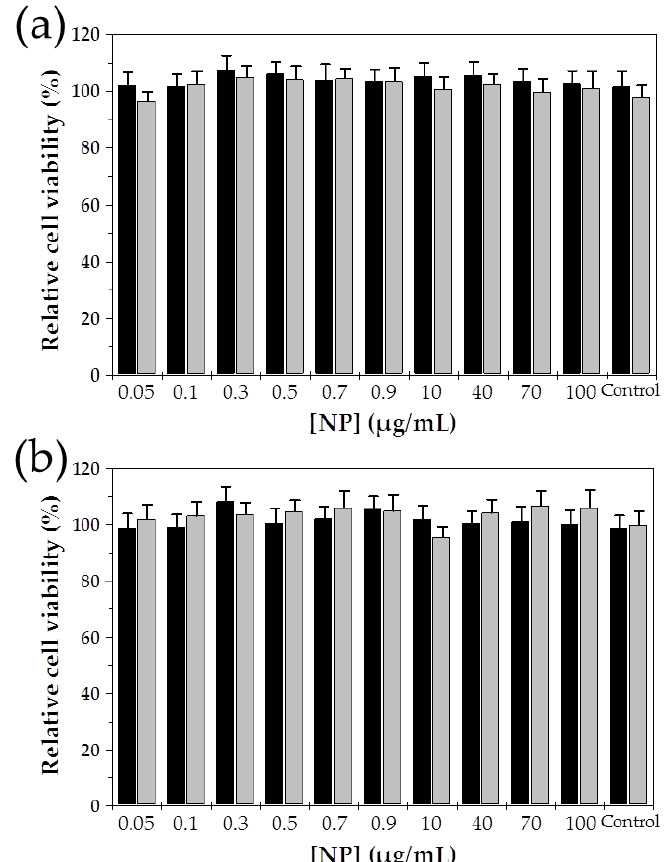
Figure 7. In vitro cytotoxicity of the Fe 3 O 4 / PCL NPs (of 2:4 Fe 3 O 4 :PCL weight ratio) in: ( a ) CCD-18 human colon fibroblast cells, and ( b ) MCF-7 human breast cancer cells. Cell lines were kept in contact with the particles for 48 h (black column) and 72 h (light grey column).